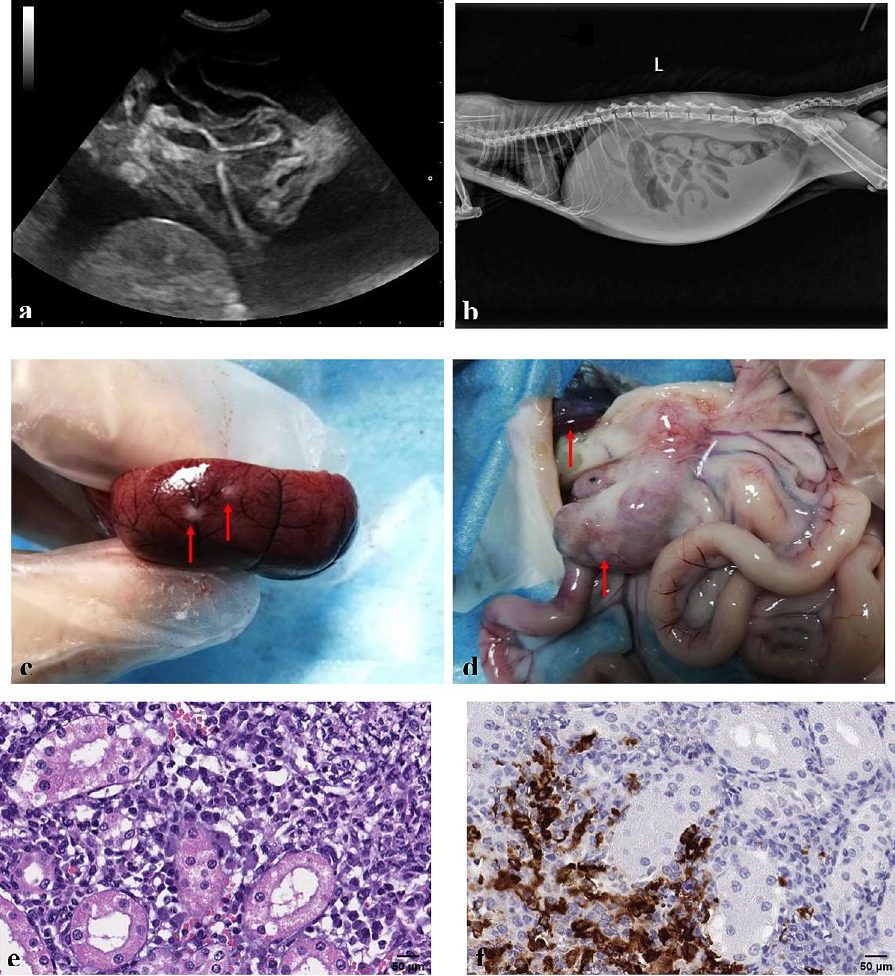
Figure 2. Clinical examination results of a 4-month-old intact female British shorthair cat with effusive FIP. ( a ) The ultrasound showed a large amount of ascites, in which the intestine was floating; ( b ) radiography revealed a large amount of effusion in the abdominal cavity; ( c ) the surface of kidney was scattered with miliary white nodules; ( d ) ascites and enlarged mesenteric lymph nodes were observed. ( e ) Moderate focal pyogranulomatous interstitial nephritis (haematoxylin and eosin stain, × 400). The interstitium of the cortex showed a focal marked infiltration with macrophages, lymphocytes, neutrophils and some plasma cells; ( f ) renal macrophages were stained strongly positive for FCoV antigen with immunohistochemistry, ×